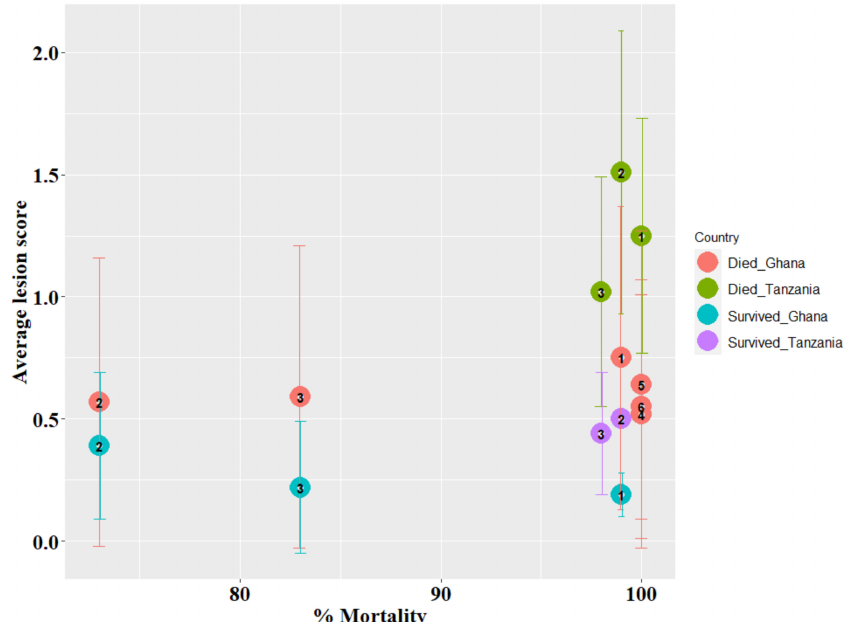
Figure 3. Average lesion scores and standard deviation bars for birds that died and survived for each replicate in Ghana and Tanzania, as identified by the colors and numbers, plotted against the % mortality in the corresponding